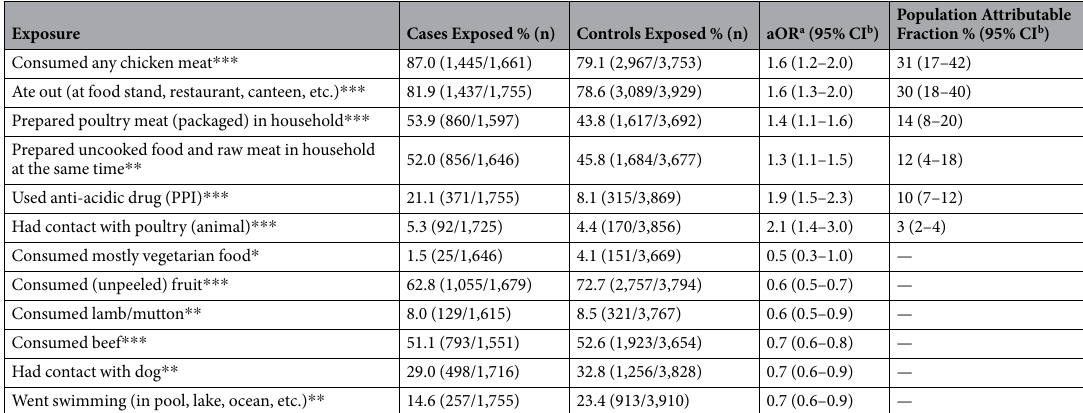
Table 3. Factors positively associated (risk factors) and factors negatively associated with Campylobacter infections. Case-control study, Germany, 2011–2014. The proportion of exposed cases and controls was based on the number of cases and controls with complete answers in univariable analysis (without adjustment for age group, sex, federal state). Adjusted odds ratios (aOR) were determined in multivariable logistic regression analysis (adjusted for age group, sex, federal state; 1,003 cases and 2,569 controls with complete answers for all variables in the final model). a Adjusted odds ratio. b Confidence interval. * Indicates P < 0.05. ** Indicates P < 0.01. *** Indicates P <